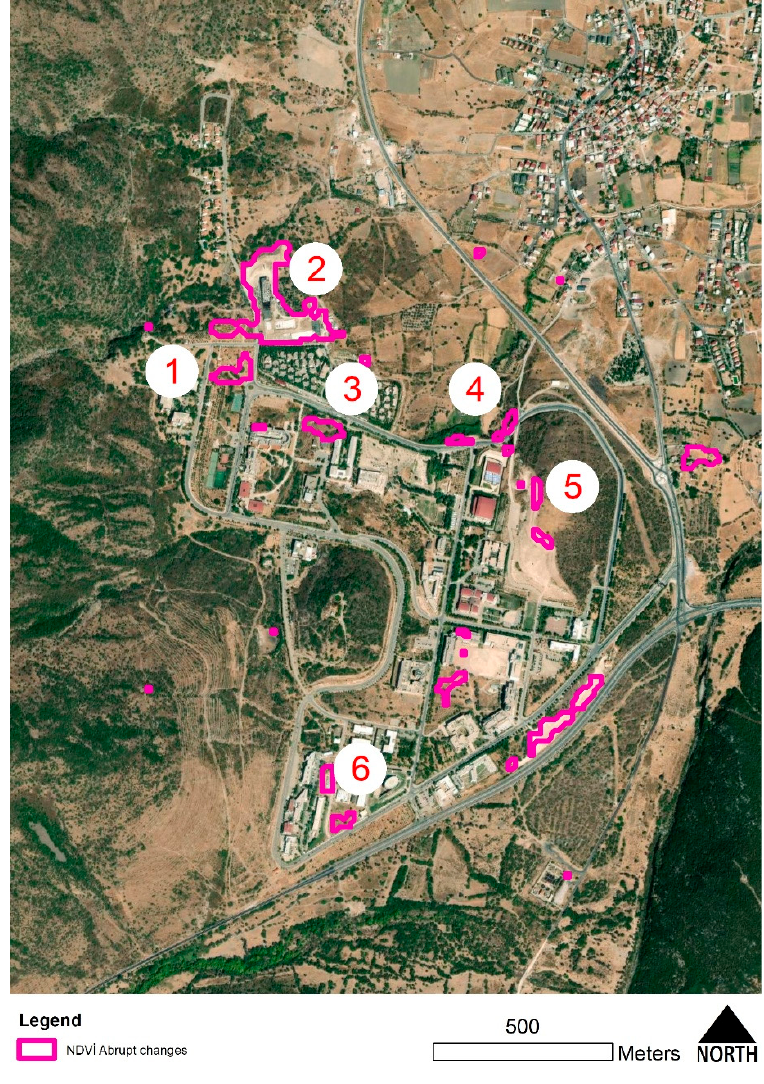
Figure 4. The final map of NDVI abrupt changes.